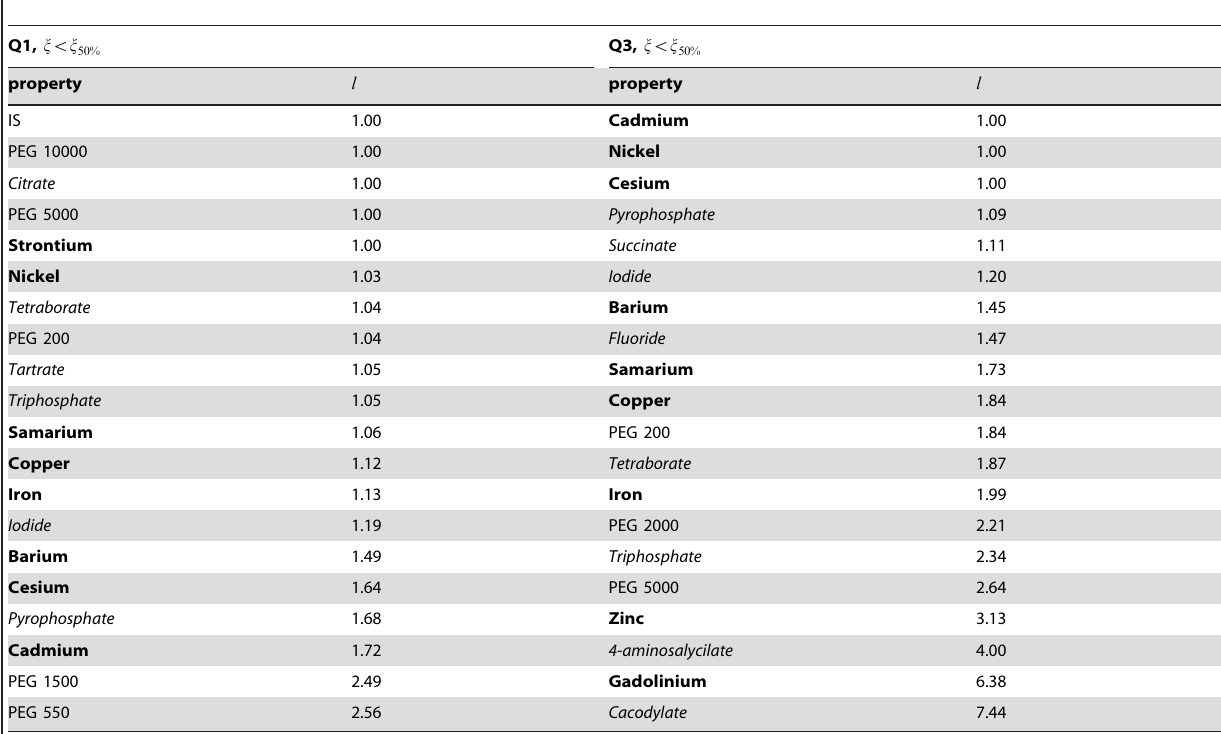
Table 3. Significant experimental conditions for hard-to-crystallize proteins belonging to Q1 and Q3.